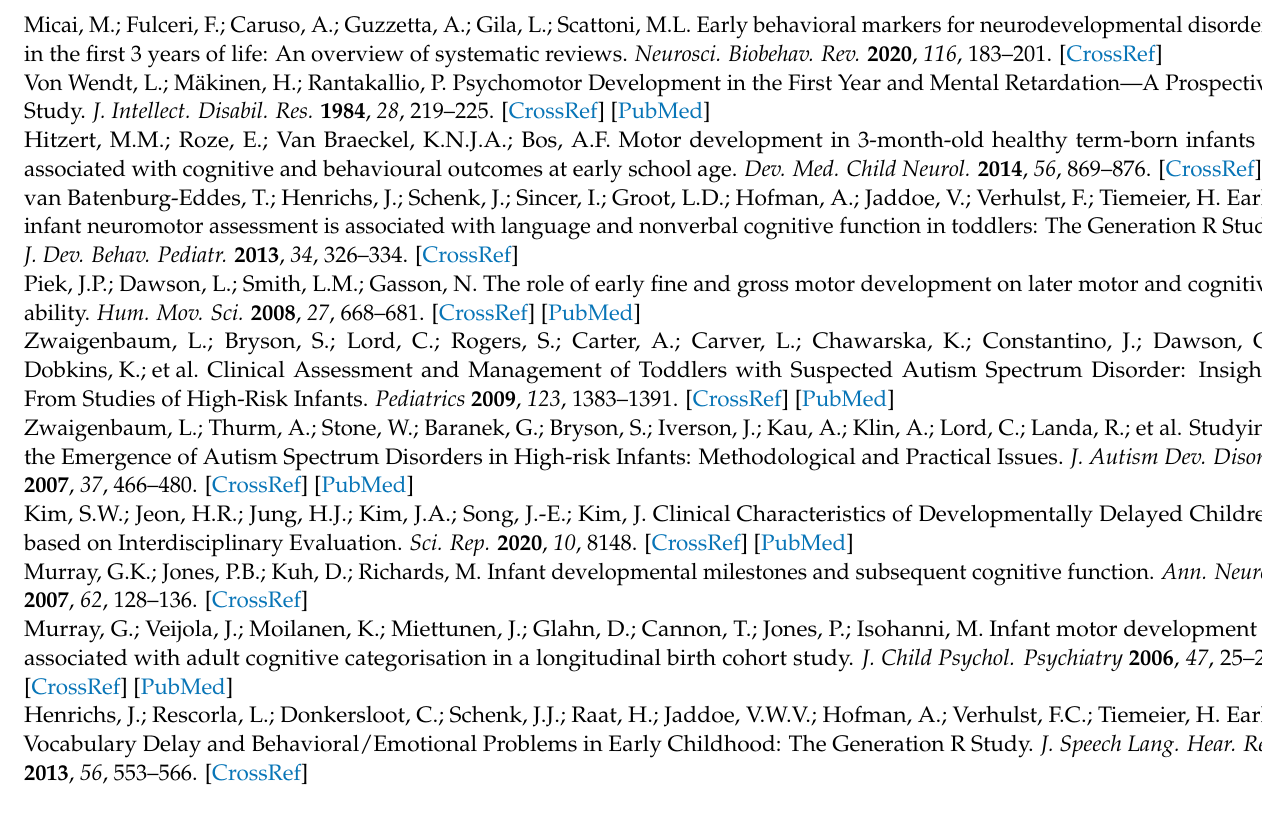
Table S3. Stratified analyses of infancy developmental milestones and childhood neurocognitive function and behavioral problems by sex; Table S4. The odds ratio (OR) and 95% confidence interval (CI) for latent profiles of childhood neuro-development at age 9–10 according to delays in infancy milestones